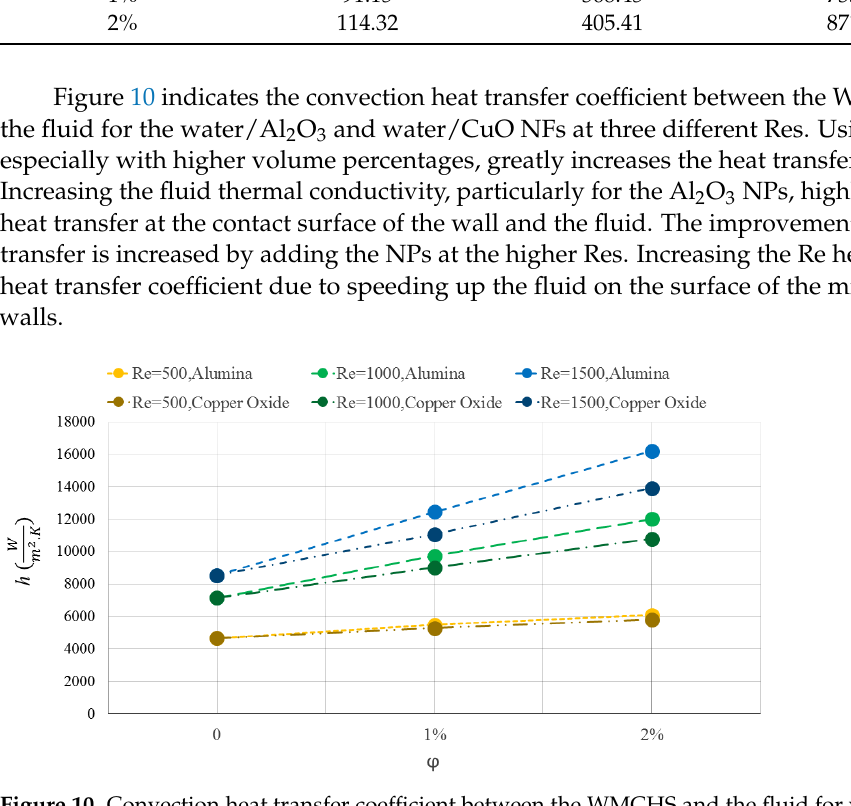
Figure 10. Convection heat transfer coefficient between the WMCHS and the fluid for water/Al 2 O 3 and water/ 𝐶𝑢𝑂 NFs at three different Res.